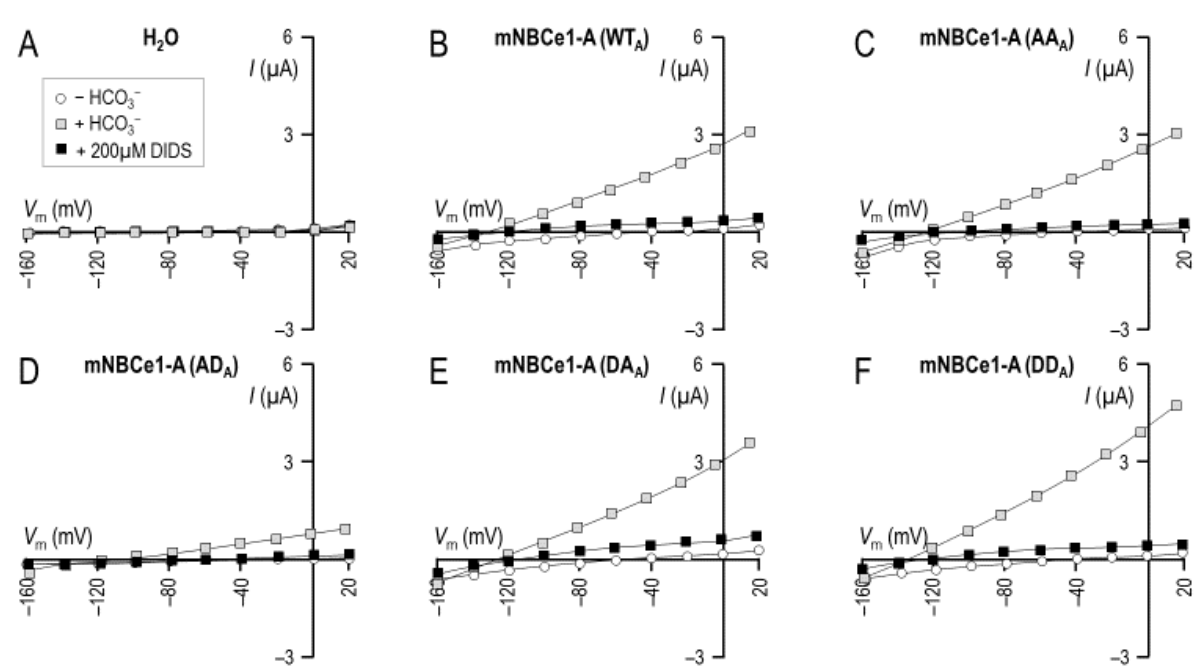
Figure 4. I–V relationships for oocyte expressing (de)phosphomimetic NBCe1-A clones. Each panel shows data gathered from a single representative oocyte injected with either ( A ) H 2 O, ( B ) cRNA-encoded wild-type NBCe1-A, or ( C – F ) cRNA encoded with one of five (de)phosphomimetic mutants. Open circles are I–V data gathered from oocytes during perfusion with our CO 2 /HCO 3 − -free solution, gray squares are I–V data gathered during perfusion with our CO 2 /HCO 3 − -containing solution, and black squares are I–V data gathered during perfusion with our CO 2 /HCO 3 − -containing solution plus 200 µM DIDS.